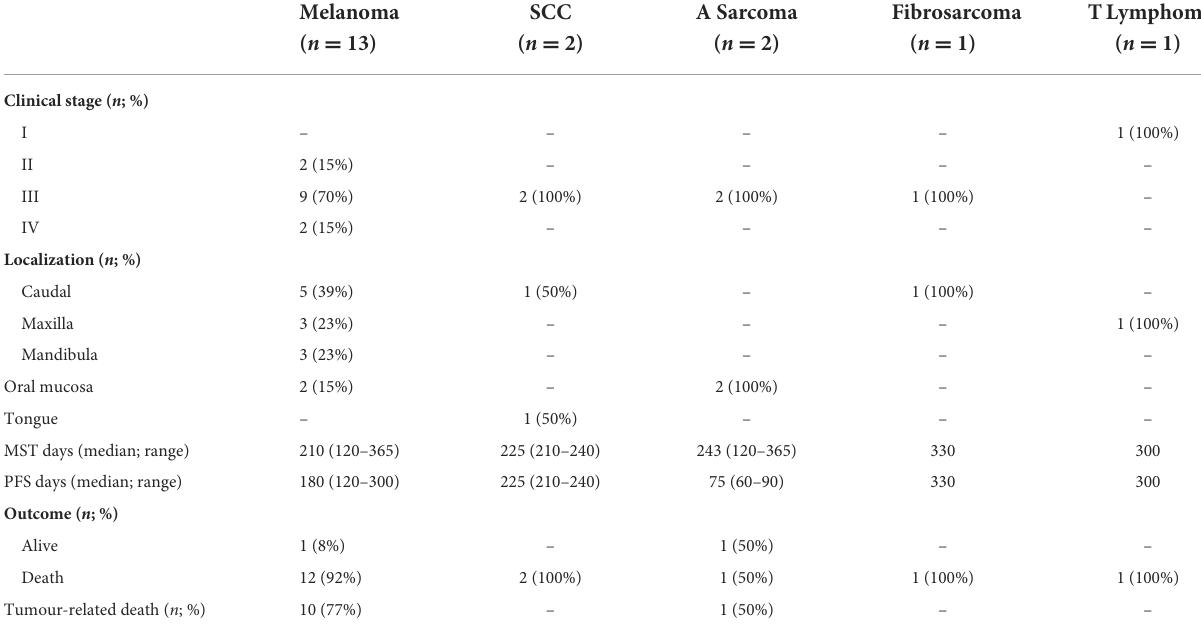
TABLE 3 Patients’ data for clinical stage, tumour localization, MST, DFI, outcome and tumour-related death grouped for tumour